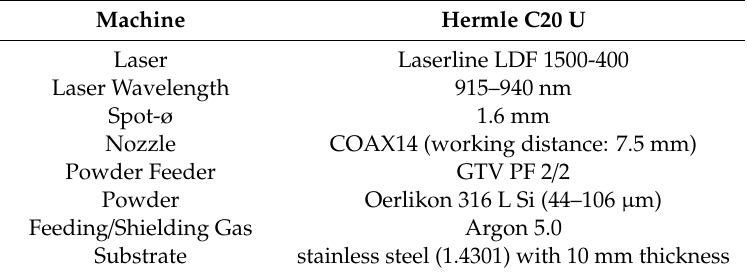
Table 1. LMD machine